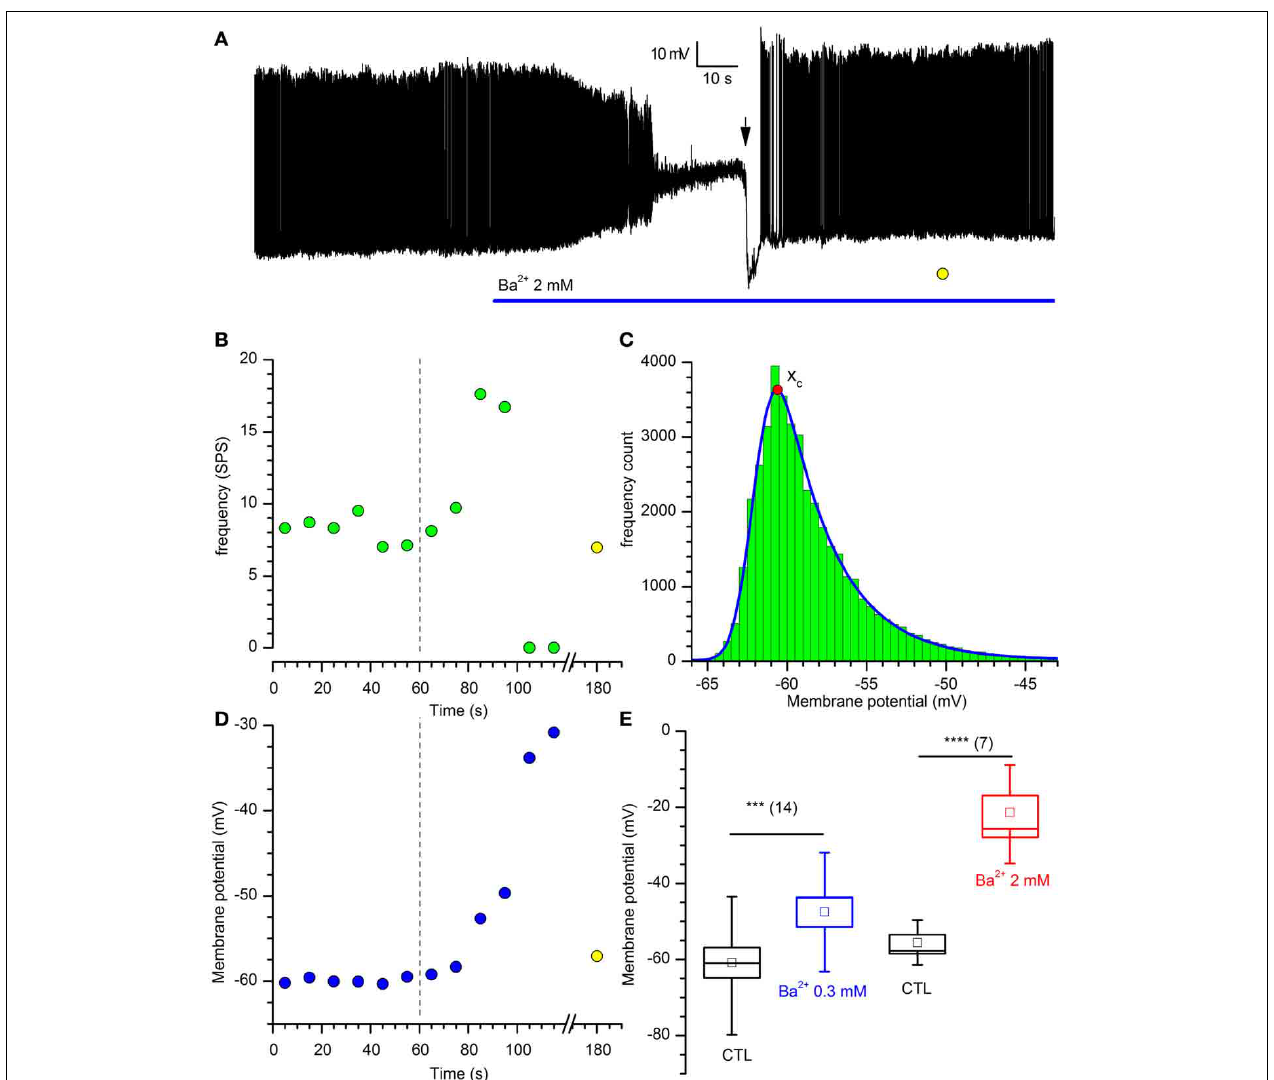
FIGURE 4 | Effects of Barium on DA-PG cells. (A) Effect of Ba 2 + on membrane potential. Perforated patch recording in standard saline (EC1 solution). The blue bar indicates the time of application of 2mM Ba 2 + into the bath; starting at the time indicated by the downward arrow, a 40 pA hyperpolarizing current was injected; (further explanation in the text). (B) Frequency analysis of action potentials (SPS, spike per second) for the experiment shown in panel A; the dashed line marks the time at which Ba 2 + has been applied and the yellow point after the x-axis interruption is a measure of the activity after the injection of a hyperpolarizing current, at the time marked by a yellow point in (A) . (C) Illustration of the method used for the calculation of the prevailing membrane potential (further explanation in